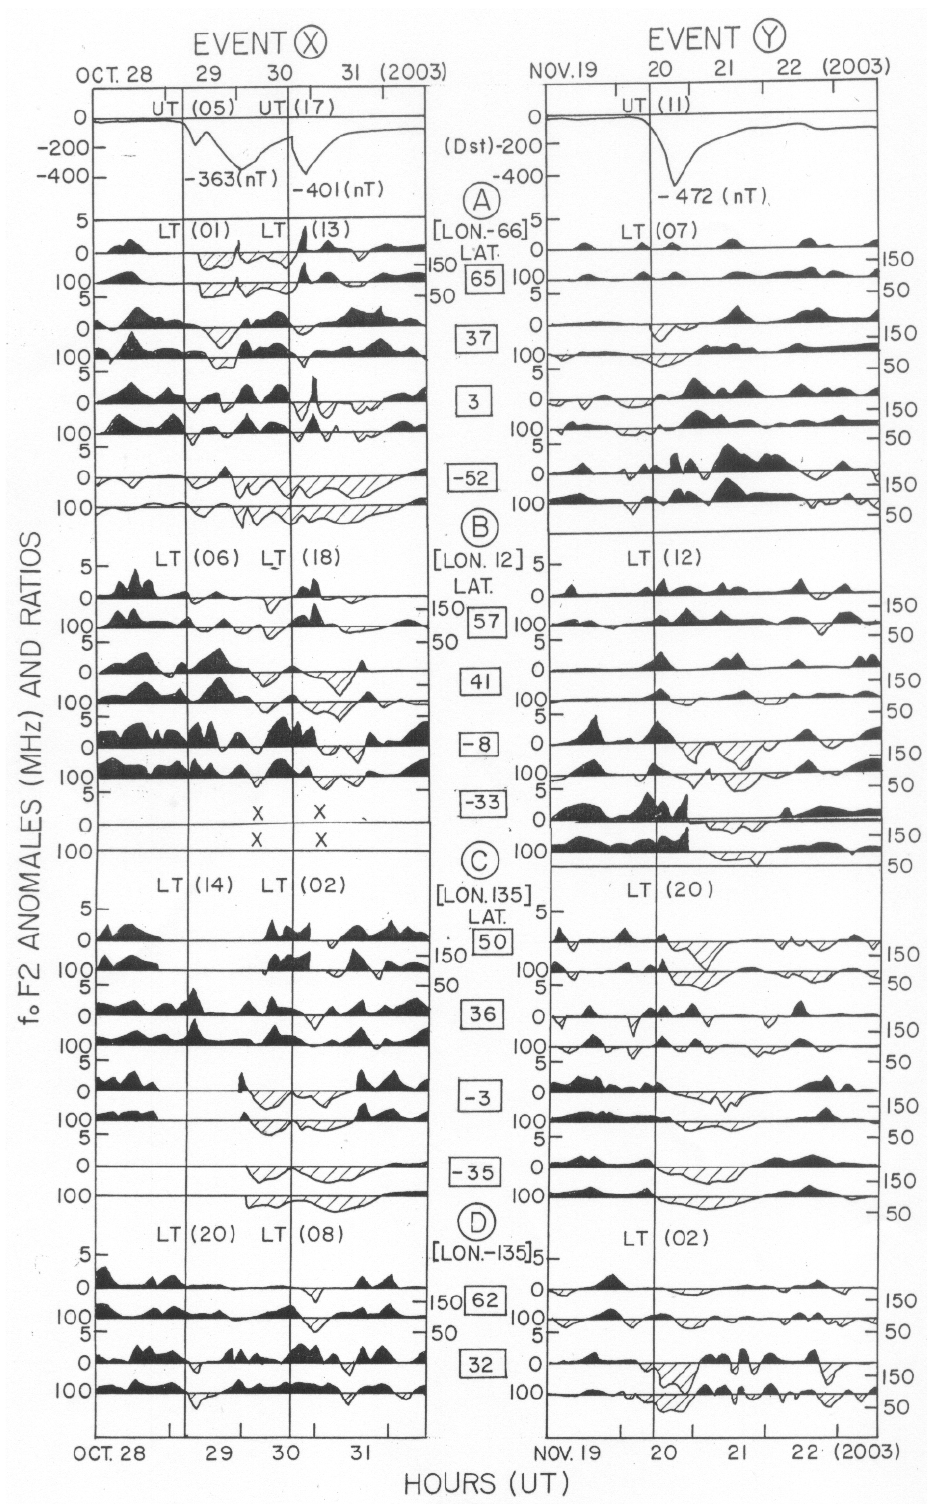
Fig. 4. Plots for Event X (28–31 October 2003) in the left half and Event Y (19–22 November 2003) in the right half, for D st (top plots) and the f o F2 anomalies (MHz) and ratios (one below the other) for averages of stations in different average latitudes (north to south, indicated in the middle) and average longitudes (A) − 66 ◦ i.e. 66 ◦ W, (B) + 12 ◦ i.e. 12 ◦ E, (C) + 135 ◦ i.e. 135 ◦ E and (D) − 135 ◦ i.e. 135 ◦ W. Vertical lines mark the storm commencements. Positive deviations are painted black, negative deviations are shown as